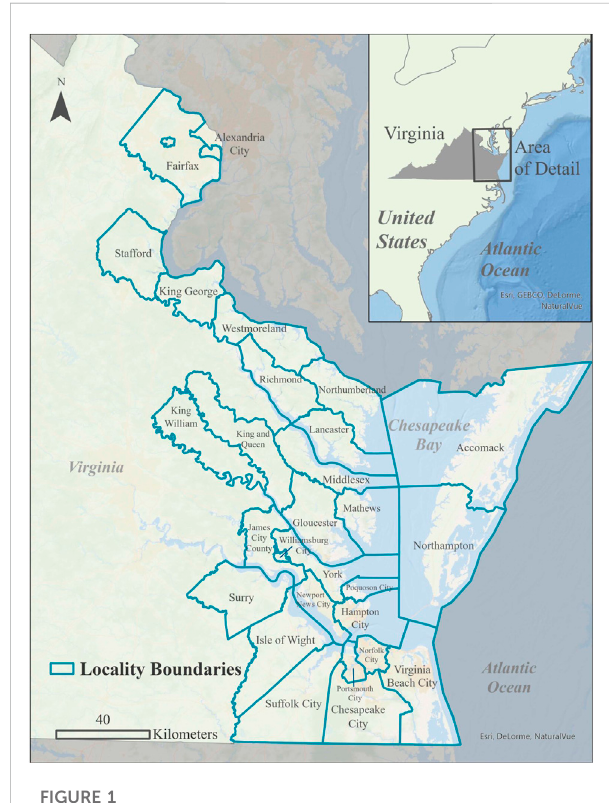
FIGURE 1 Map of Chesapeake Bay, Virginia with low elevation coastal localities. Blue boundaries represent the localities used in this